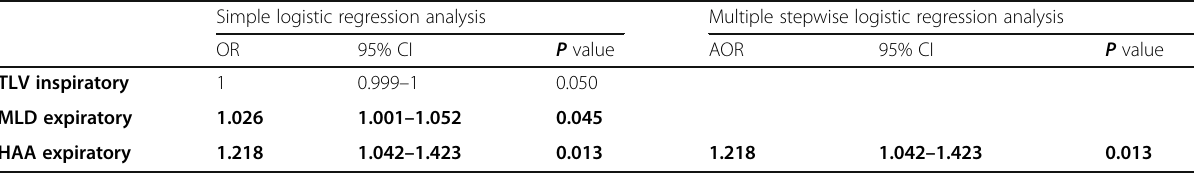
Table 4 Logistic regression analysis for prediction of severe HRCT in patients with interstitial lung disease Simple logistic regression analysis Multiple stepwise logistic regression analysis